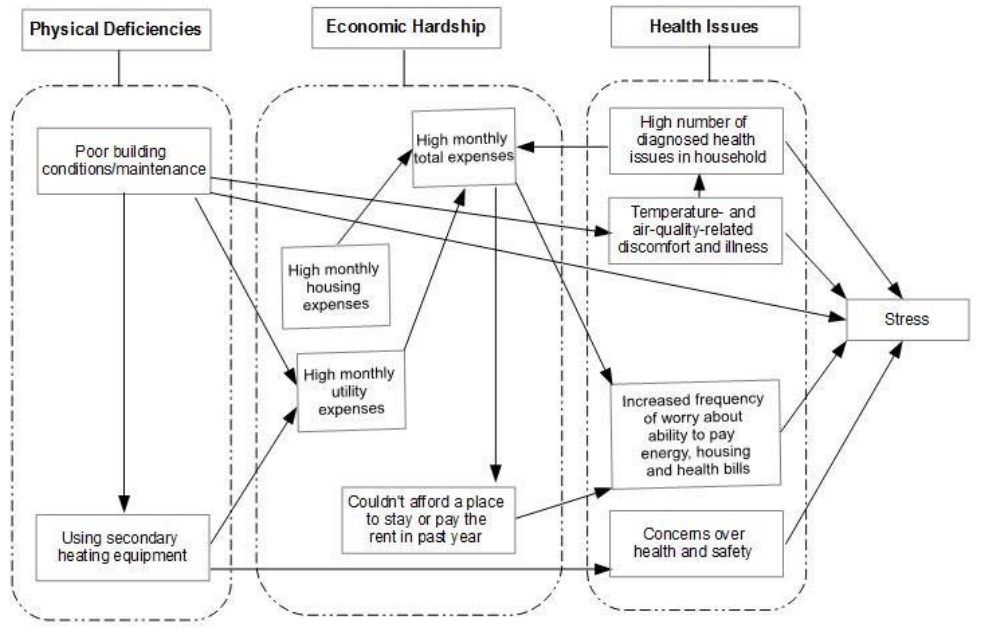
Figure 1. Housing, energy and health pathways to stress.